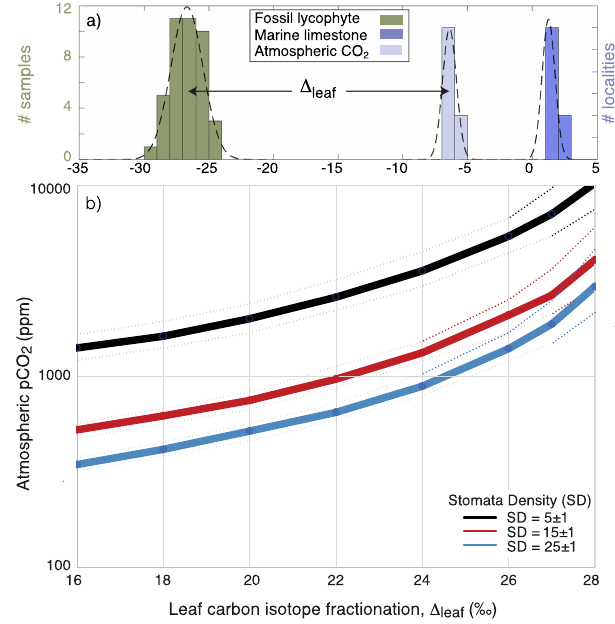
Fig. 1 | Atmospheric pCO 2 levels are derived from leaf carbon isotope fractio- nation ( Δ leaf ), Stomata Density (SD), and stomata pore length (p). a Δ leaf is determined from the carbon isotope composition ( δ 13 C) of the fossil fl ora (green), marine carbonates (blue) and calculated atmospheric CO 2 (light blue) (Supple- mentary Table 4). b Plants grown under higher ambient CO 2 levels yields a higher Δ leaf and/or lower stomata density. The curves represent gas-exchange model calibratedformodernlycophyteswithareferenceCO 2 assimilationrateatmodern atmospheric levels (A 0 ) of 3.5 µ mol m − 2 s − 1 , an operational stomatal conductance ef fi ciency (ratio of operational to maximal stomatal conductance) ζ = 0.2, stomata poreshape β =0.6andp=18±2 µ mcomparabletoancientandmodernlycophytes (see supplement for details). Here, a fossil lycophyte from the Devonian is used as an example. Devonian lycophytes typically display Δ leaf values close to 20 ‰ and stomata densities between 15 and 25mm − 1 (Supplementary Data